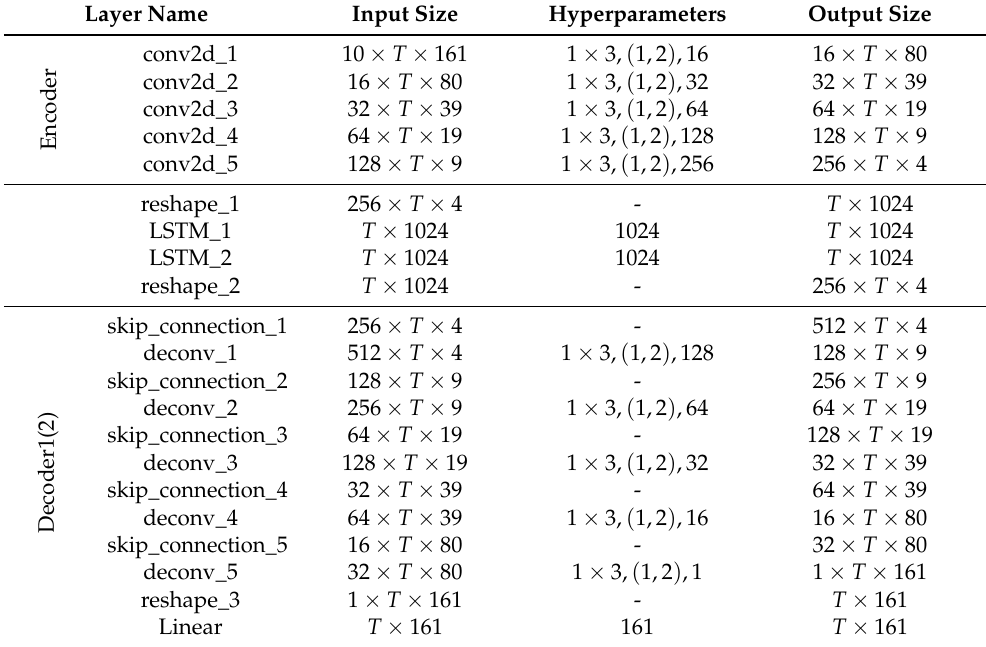
Table 1. Detailed parameter setup for